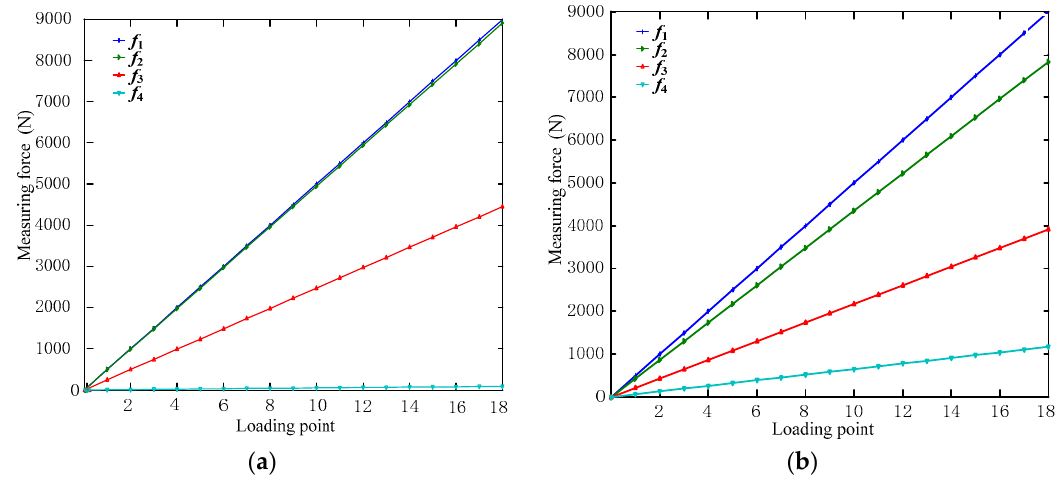
Figure 7. Output values of a measurement module accounting for ( a ) rolling friction and ( b ) sliding friction.